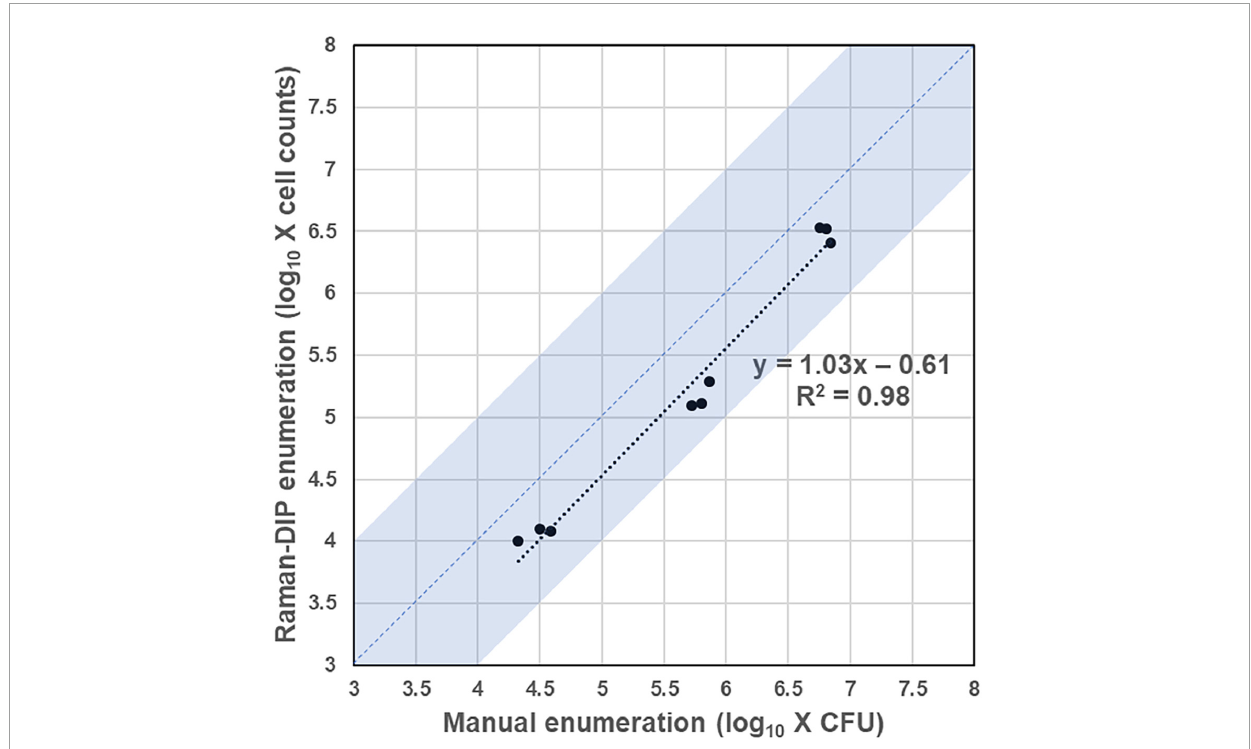
FIGURE5 Enumeration results from the Raman-DIP method and the conventional plate-counting method. Samples with a consistent enumeration will locate in the blue